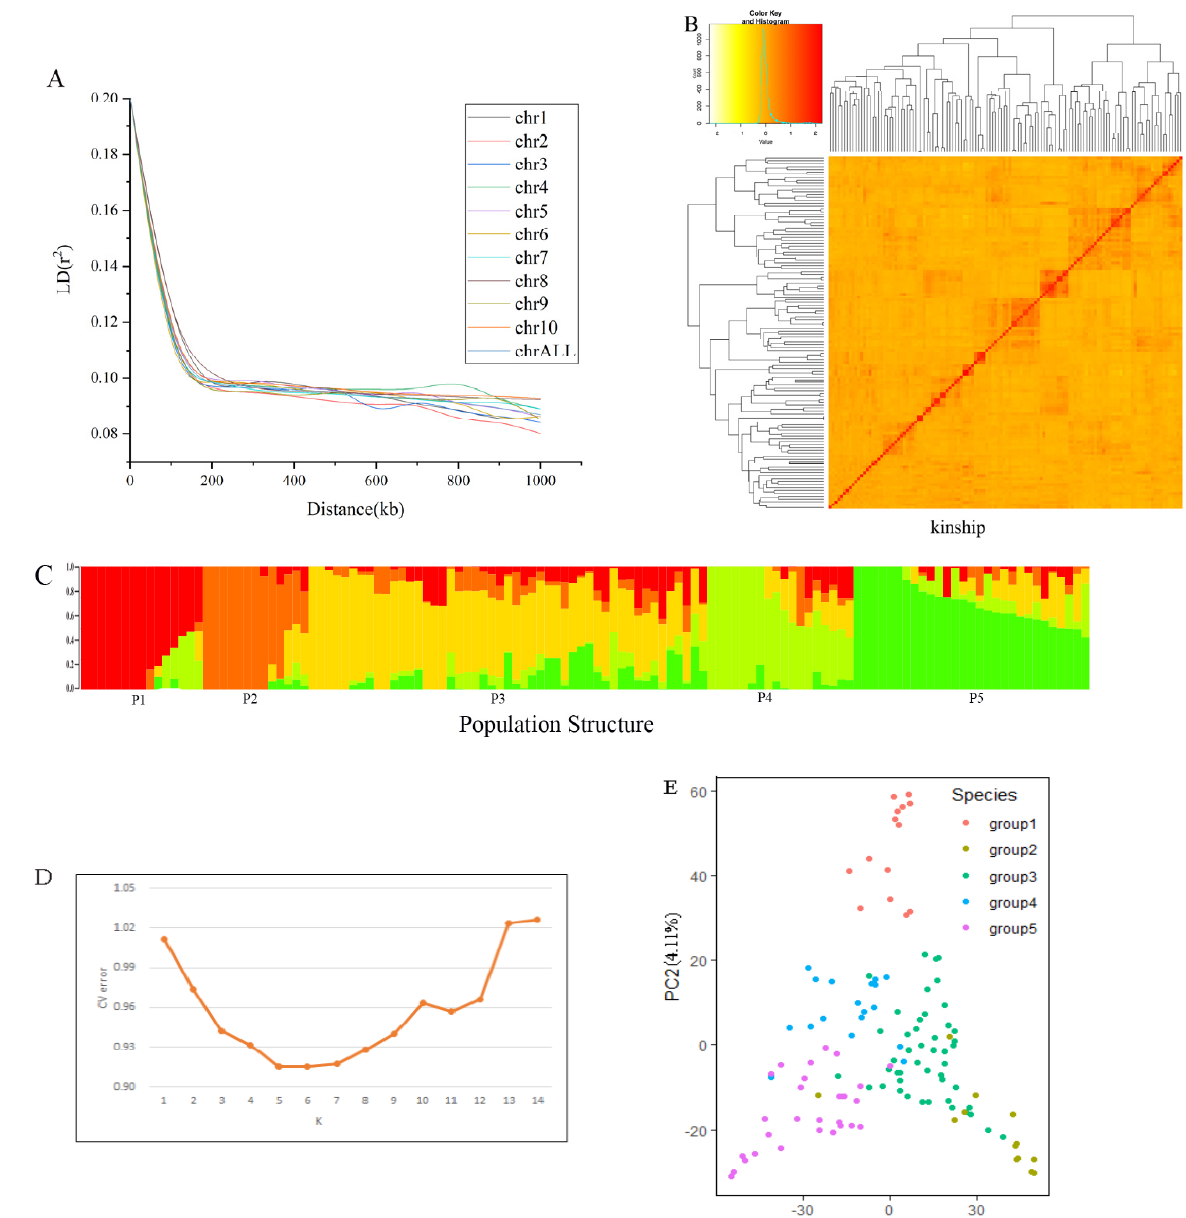
Figure 3. Group structure and genetic relationship analysis of related groups. ( A ). Linkage dise- quilibrium decay diagram. LD refers to the non-random association of alleles at different loci in a population; ( B ). Relationship analysis of association population; ( C ). Structure analysis results of association population. P1-P5 represent five distinct subpopulations. Different colors represent different ancestral subgroups. There are different colors in a bar, indicating that this inbred line is a cross between multiple ancestral subgroups; ( D ). Structure analysis of related populations. CV refers to the error value of cross-validation. The K value is the estimated number of distinct ancestral groups. The smaller the CV value, the more reliable the K value; ( E ). Principal component analysis. PC1 and PC2 were the two principal components that could explain most of the